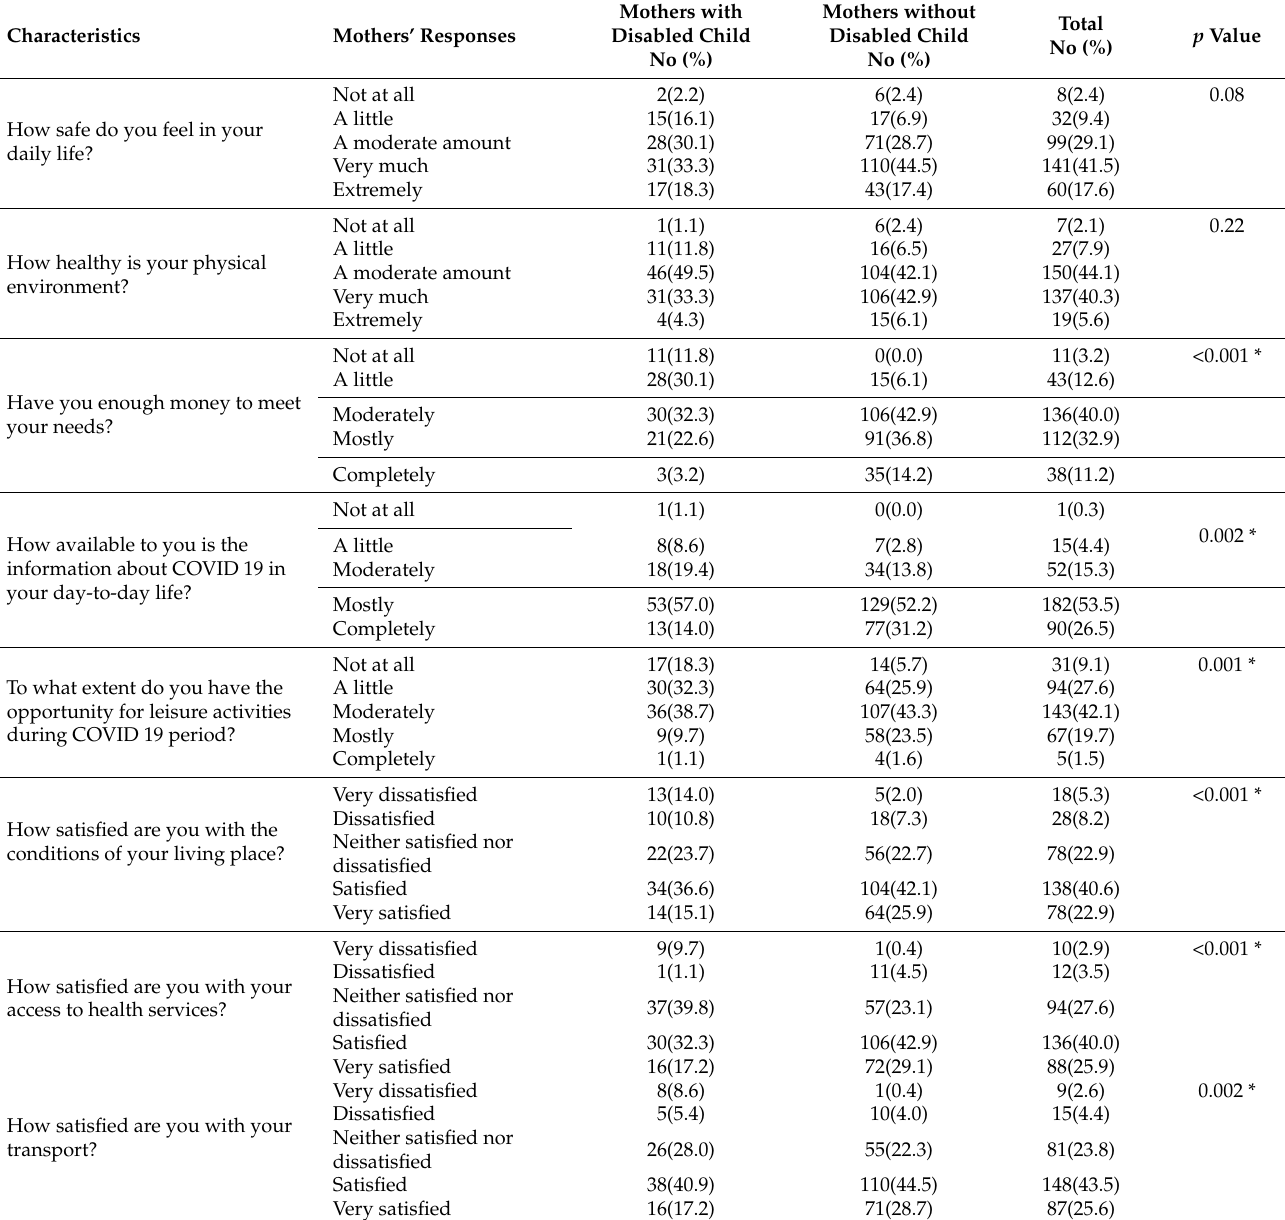
Table 3. Comparing environmental well-being among mothers of children with disabilities and mothers of children without disabilities during the COVID- 19